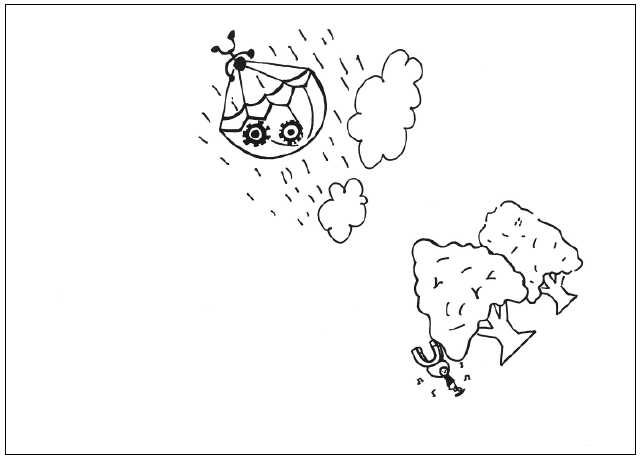
Figure 7. Work by D1 No Depression.